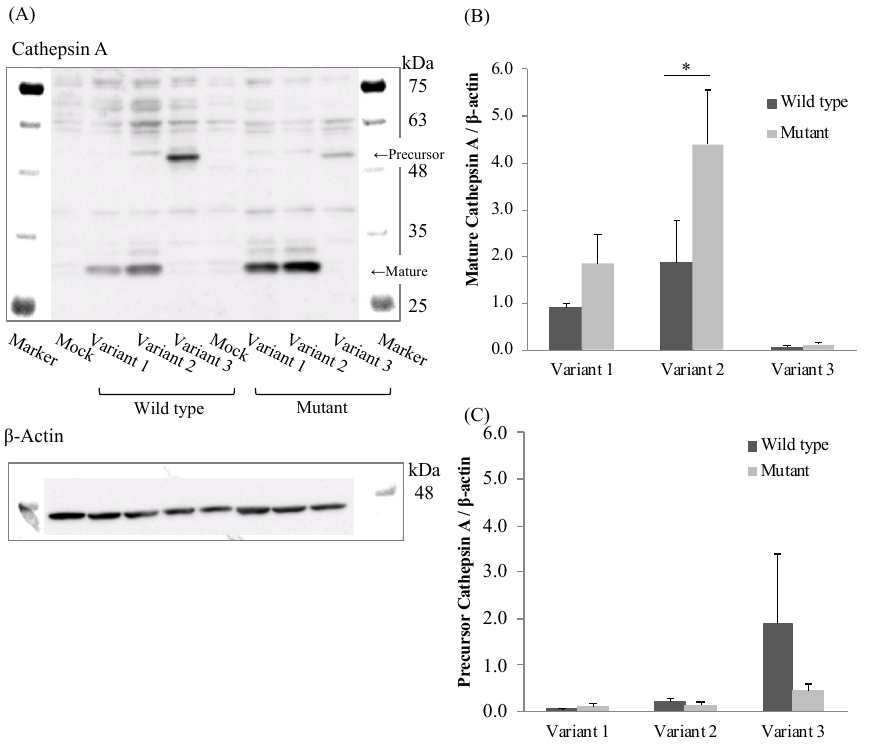
Figure 4. Western blotting analysis in stably Cathepsin A expressing Flp-in 293 cells. ( A ) Cathepsin A precursor, mature and β -actin. ( B ) Densitometric analysis was shown for precursor Cathepsin A/ β -actin of the blots. ( C ) Densitometric analysis was shown for mature Cathepsin A/ β -actin of the blots. The data represented as mean + S.D. of triplicate experiments. ( t test * p < 0.05).